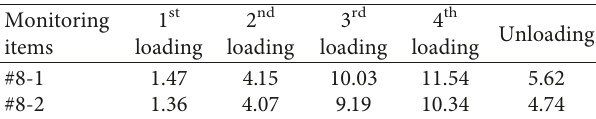
Table 3: Absolute height value of the bottom of the box girder (unit: m).